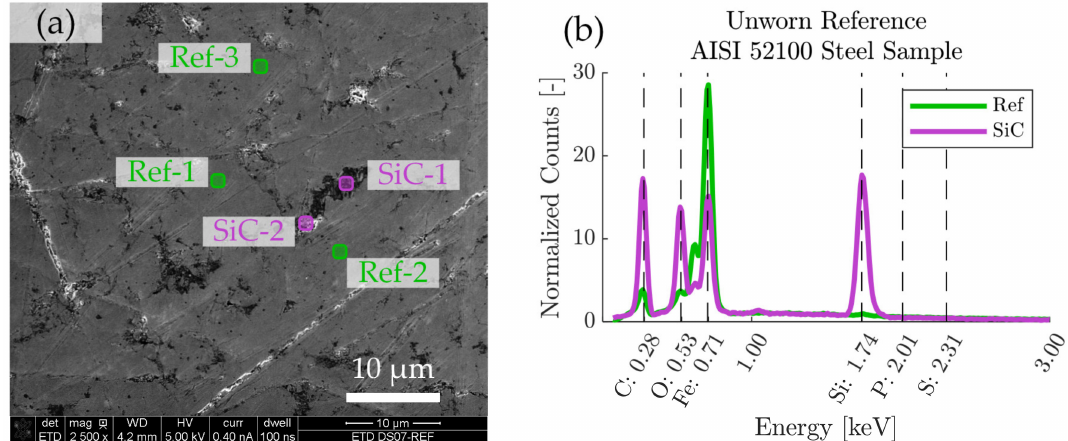
Figure 1. SEM-EDS characterization of reference AISI 52100 steel sample. ( a ) SEM image showing locations of analyzed regions of interest, consisting of three reference regions (Ref-1–3) and two regions rich in silicon-carbon (SiC-1–2). ( b ) Average EDS spectra corresponding to the Ref and SiC regions of